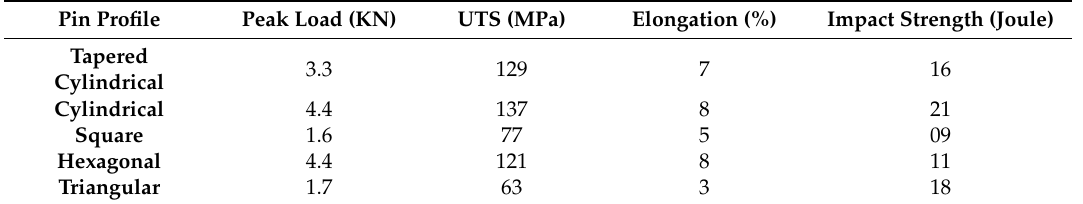
Table 6. Scarf joint configuration tensile and impact test results for different pin profiles.